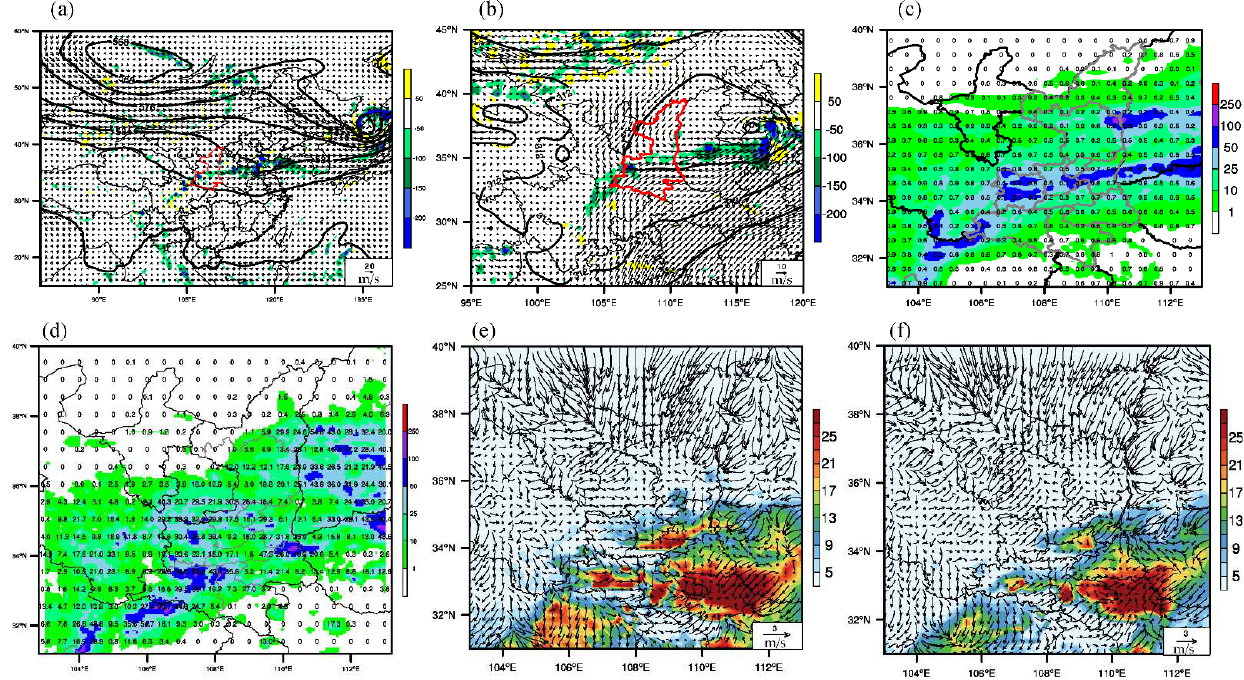
Figure 7. A case study of ECMWF model forecast from 00 UTC on 6 August to 00 UTC on 7 August. ( a ) The 500 hPa geopotential height, vertical velocity and wind field of ECMWF at 12 UTC on 23 July, which the initial time was 00 UTC on 22 July. ( b ) Same as ( a ), but for 700 hPa. ( c ) The ECMWF accumulated precipitation from 00 UTC on 6 August to 00 UTC on 7 August, and the initial time was 00 UTC on 22 July. ( d ) CMPA 24 h cumulative precipitation from 00 UTC on 6 August to 00 UTC on 7 August. ( e ) The convergence and divergence wind and Cape of ECMWF model at 12 UTC on 6 August, and the initial time was 00 UTC on 5 August. ( f ) Same as ( e ), but the initial time of the model forecast is 6 August to 15